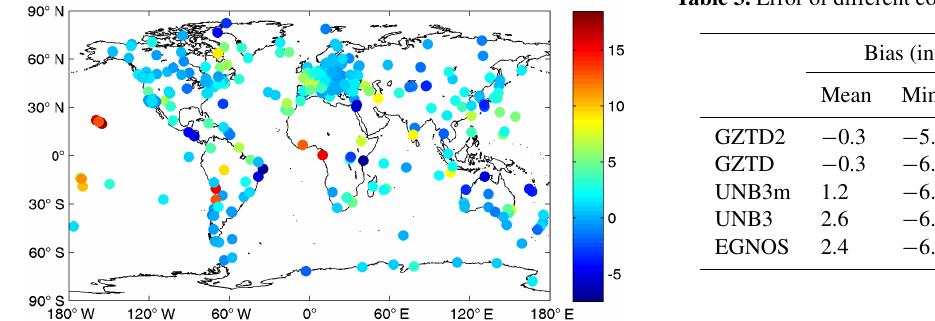
Table 3. Error of different considered models versus IGS